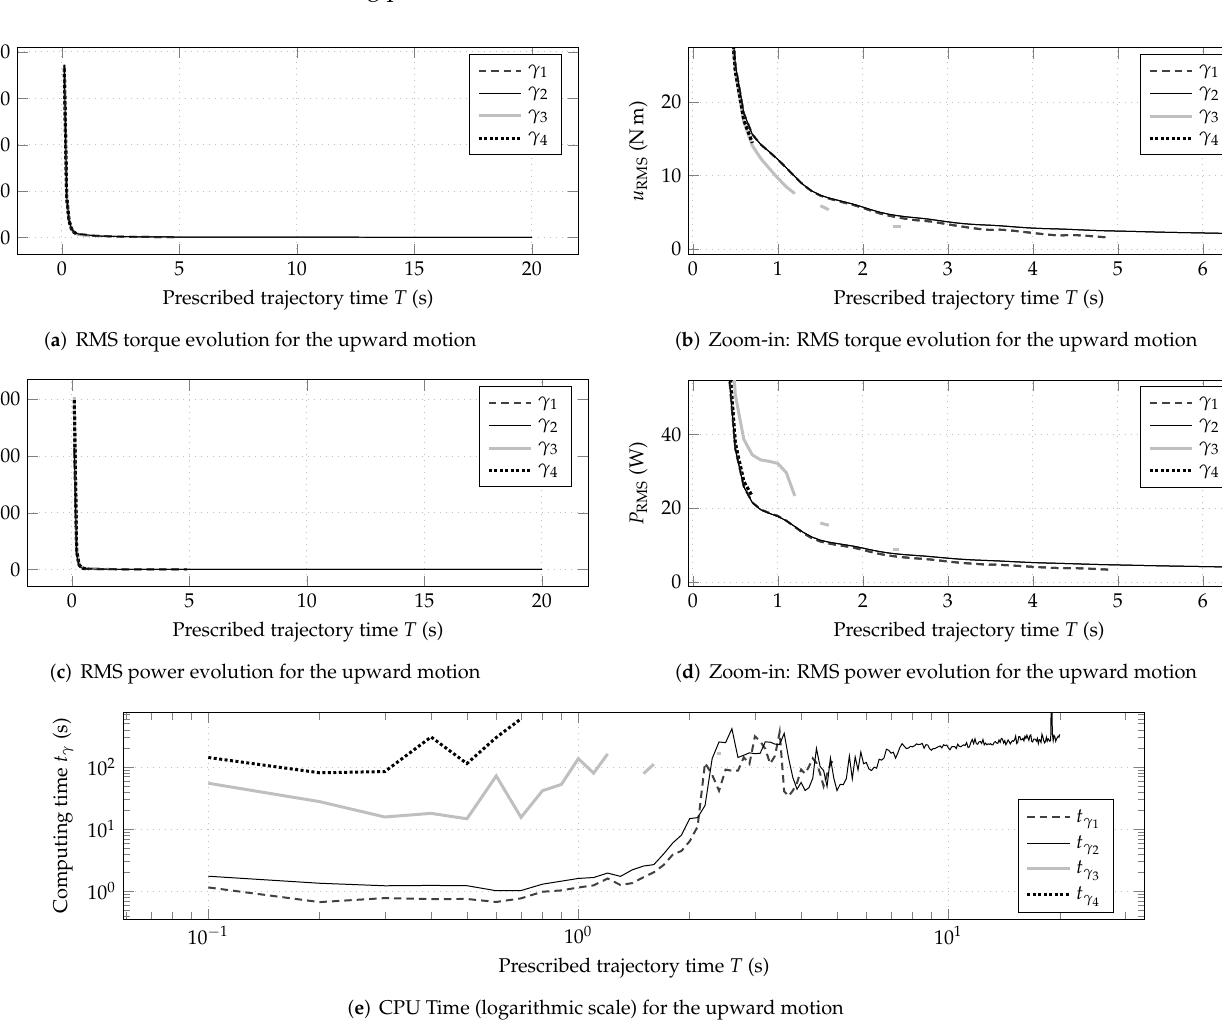
Figure 2. Upward motion (see Step 1 of Section 6.1.3): numerical solution of the optimal control of a two DOF robotic manipulator. Results for growing values of the prescribed trajectory time T : ( a ) RMS torque evolution; ( b ) cropped and zoomed-in version of ( a ); ( c ) RMS power evolution; ( d ) cropped and zoomed-in version of ( c ); ( e ) required time to compute a solution. Benefits of our invariant cost functions γ 1 and γ 2 : lower RMS power values; improved solver stability with uninterrupted results up to T = 4.9s for γ 1 and past T = 10s for γ 2 ; substantially lower computing